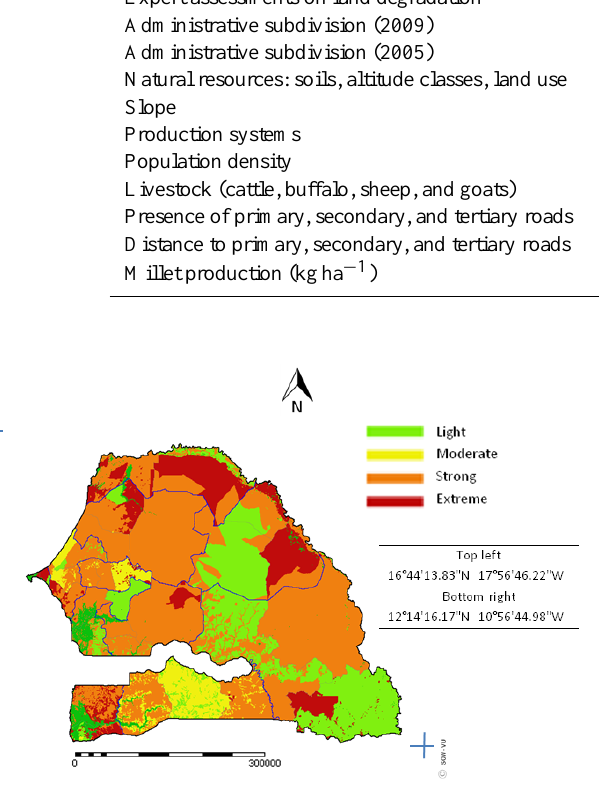
Figure 1. Average degree of land degradation.